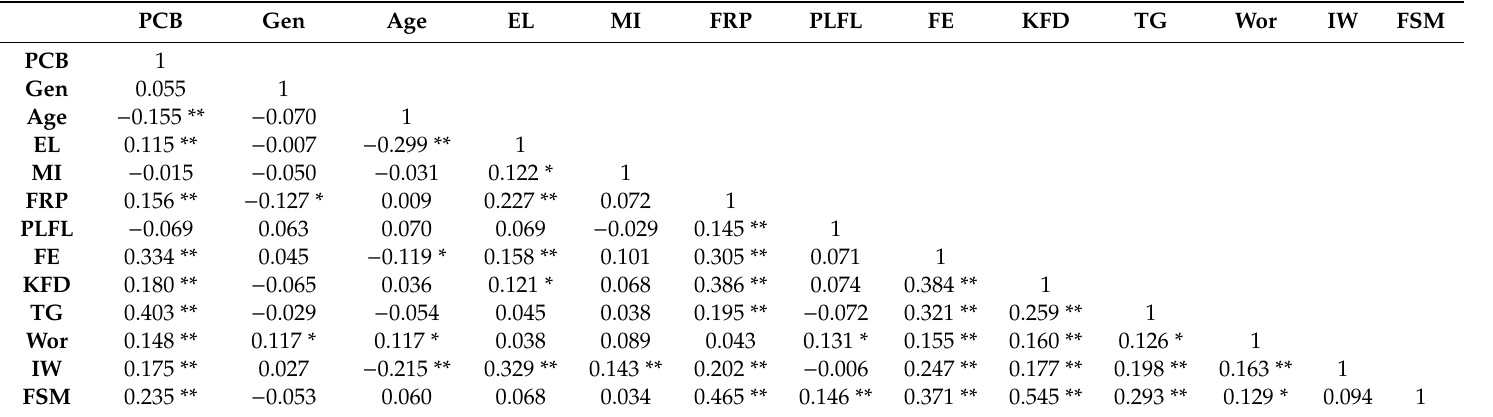
Table 4. Results of correlation analysis between influential factors and protective coping